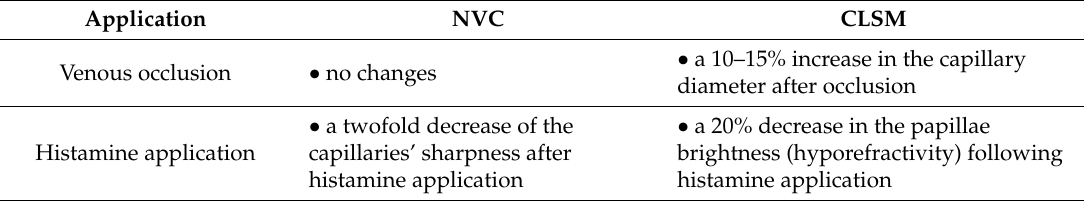
Table 1. Alterations of the NVC and CLSM parameters after venous occlusion and histamine application to the skin.